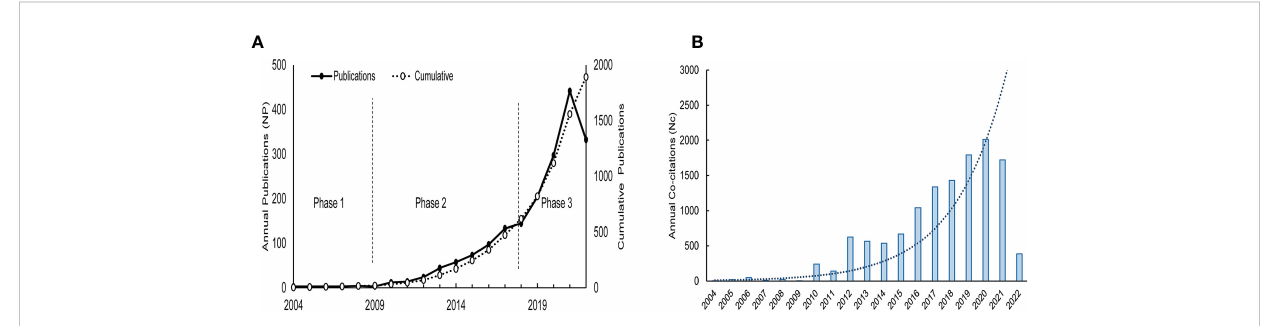
FIGURE 2 Articles related to the study of the gut-liver axis in NAFLD. (A) The Annual and cumulative publication numbers from 2004 to 2022. (B) Annual number of citations (Nc).